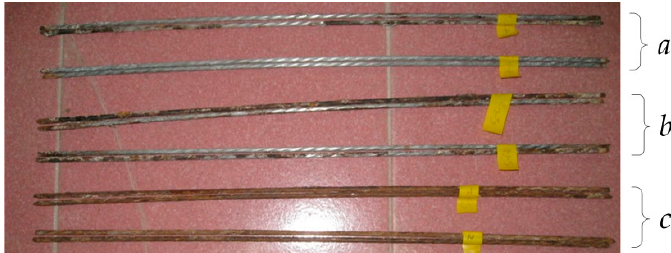
Figure 5. Corrosion of reinforcing steel: ( a ) Slight corrosion; ( b ) Moderate corrosion and ( c ) Severe corrosion.